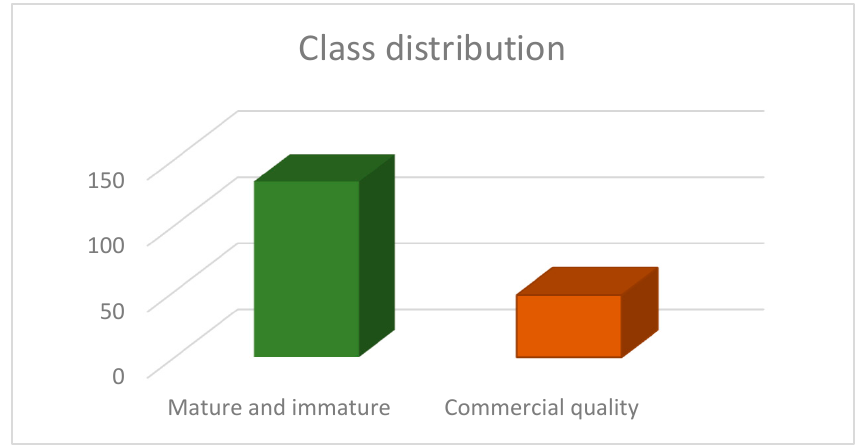
Figure 3. Distribution of ‘mature and immature’ and ‘commercial quality’ classes in the Model B dataset.